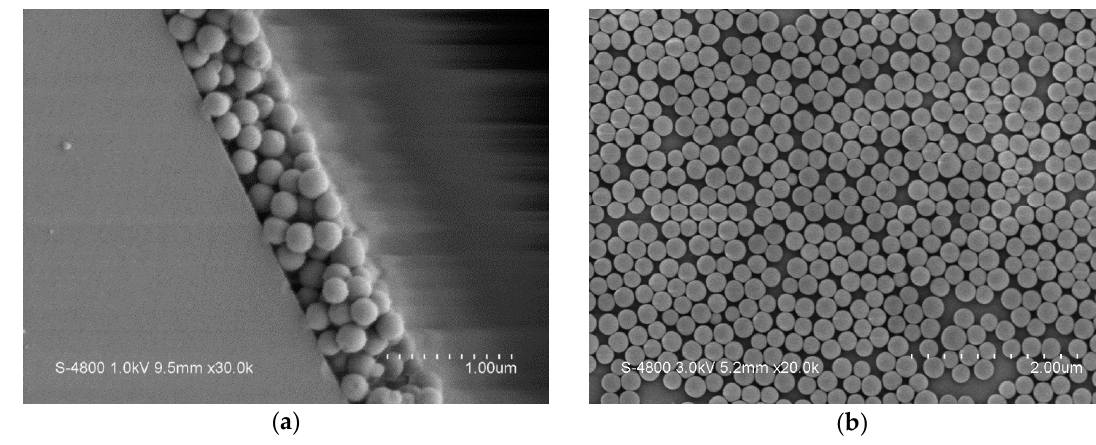
Figure 5. ( a ) A SEM image of the nano particles of the sensing thin film on the optical fiber surface; ( b ) the nano particle size and coverage are 200 nm and 73%.